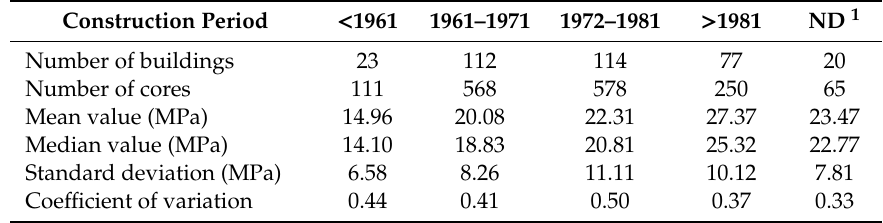
Table 1. Main statistical values of the available data on concrete strength f c .